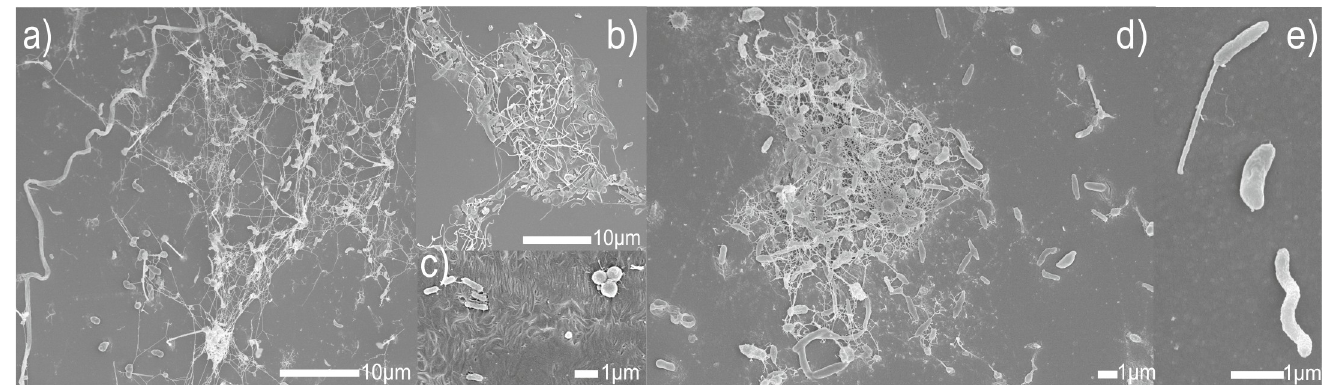
Fig 3. SEM images of colonized plastics. a) Meshwork of morphological diverse cells embedded in EPS attached to PS. b) Colony attached to PESTUR c) Single cells of rods and cocci on HDPE d) Consortia of rods and cocci embedded in EPS on PS e) Rod with spore, comma and spiral cells on PVC.